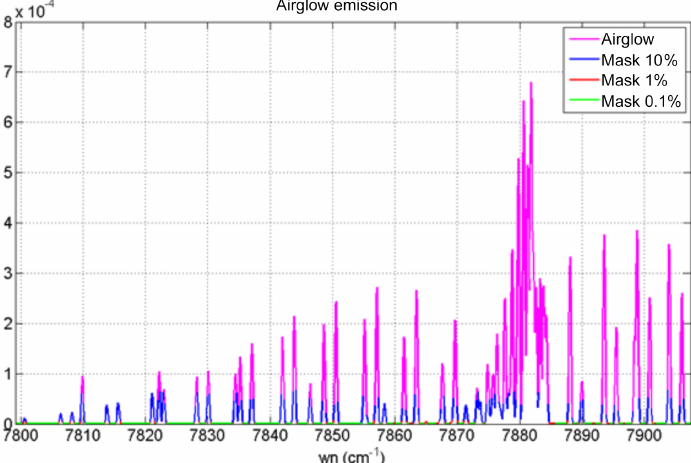
Figure D3. Airglow spectra at 1.27µm, at MicroCarb resolution, used in our tests of inversion of Psurf with method no. 2 for several values of the spectel mask: no mask (pink), 10% mask (blue), 1% mask (red), and 0.1% mask (green). The three masks remove, respectively, 14%, 31%, and 44% of the spectels in the B4 band.